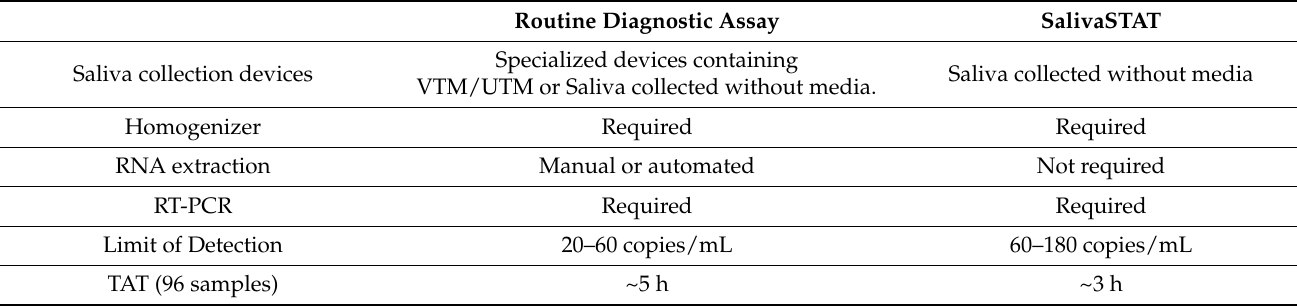
Table 1. Comparison between Routine diagnostic assay and SalivaSTAT